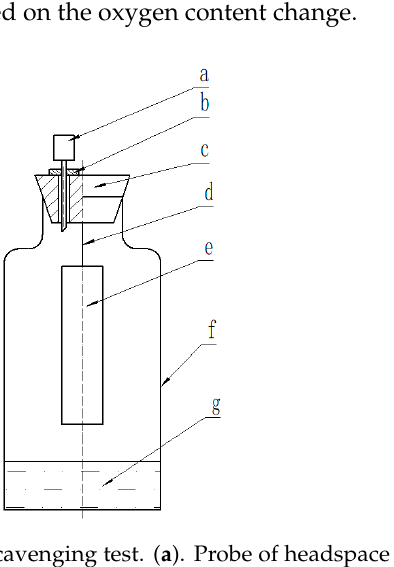
Figure 1. A closed system of oxygen scavenging test. ( a ). Probe of headspace O 2 / CO 2 analyzer; ( b ). sealing gel; ( c ). plug; ( d ). string; ( e ) sample; ( f ) 100 mL glass bottle; ( g ) saturated solution (only used in the influence of humidity).